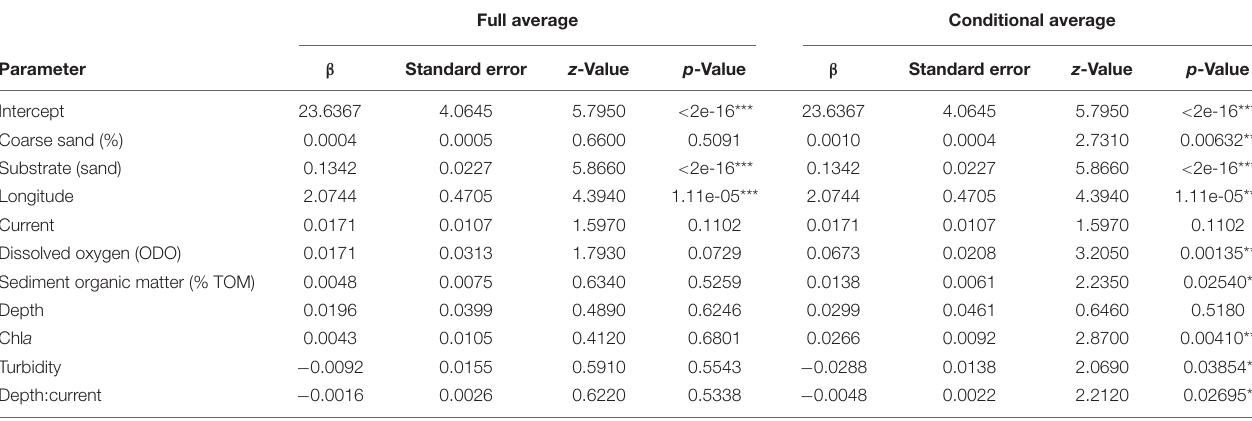
FIGURE 8 | Surface plot depicting the interaction behaviour between current and depth in the density model, explaining distribution patterns of Holothuria mammata at Arrábida, Setúbal. TABLE 3 | Fixed-effect GLM averaged model results with a Gamma distribution (averaged R 2 = 49%, as the average of all models weighted by their model weights), explaining size distribution patterns of Holothuria mammata at Arrábida, Setúbal. Full